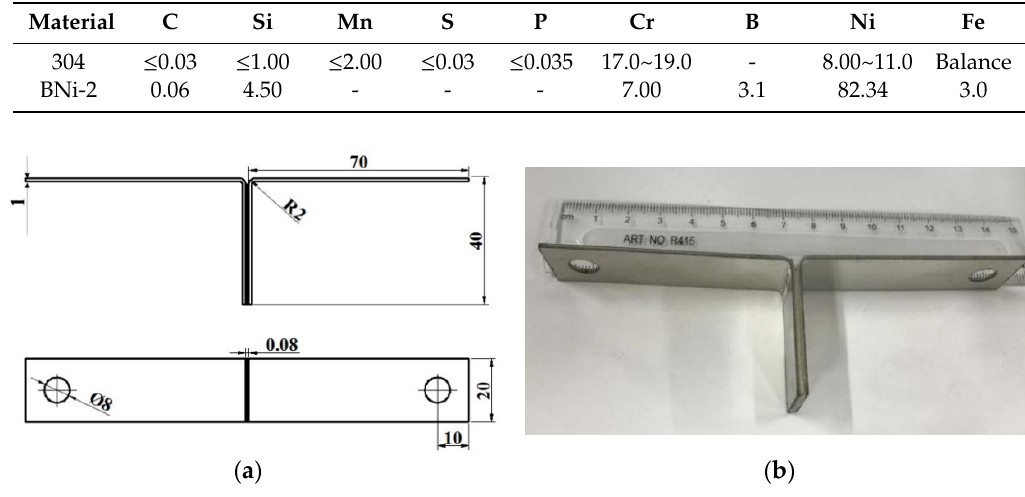
Figure 1. Specimen for a T-type brazed joint: ( a ) schematic geometry and ( b ) photograph.